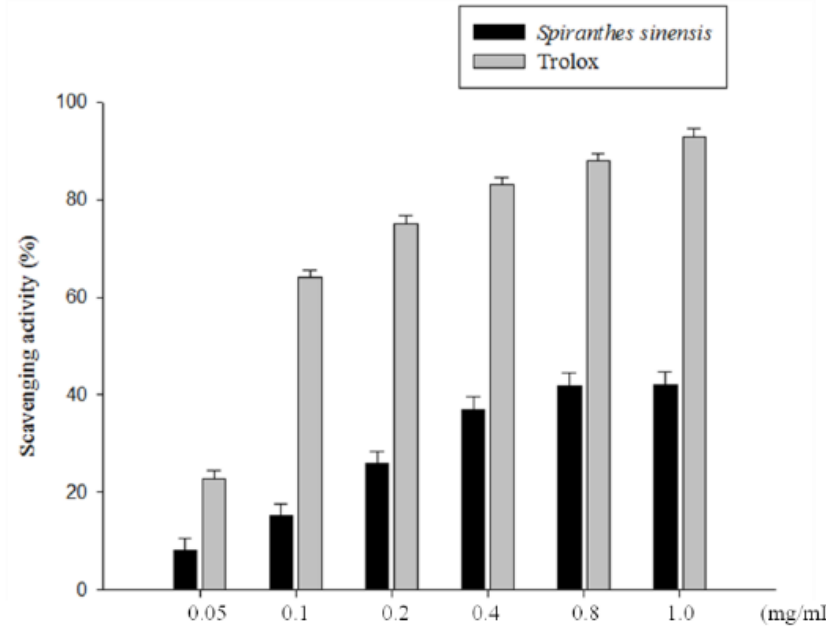
Figure 4. Total antioxidant activity of S. sinensis E+U extract. Different concentrations of the extract or Trolox were used in the study. Results are represented as percentages of control, and the data are mean ± SD for the three separate